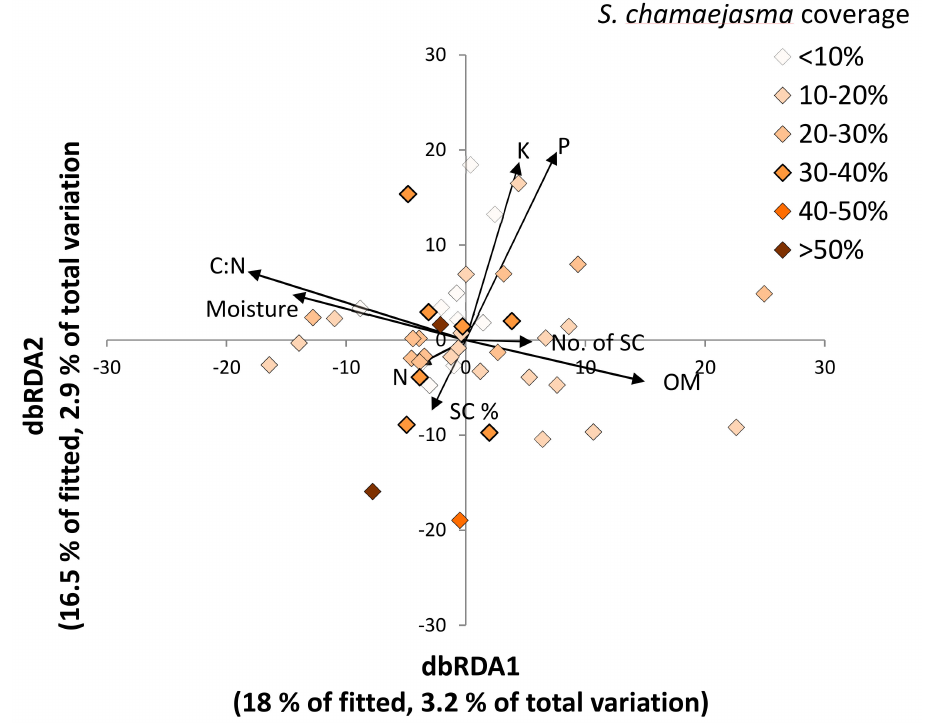
Figure 6. dbRDA plot of global fungal communities in the invaded site ( n = 46) relating variations in fungal populations with soil and S. chamaejasme cover and abundance. Invaded site only. Nutrient, moisture and organic matter are % total (C = carbon, N = nitrogen, P = phosphorous, K = potassium, moisture, and OM = organic matter). SC = % cover and abundance of S. chamaejasme per quadrat; No. of SC = number of S. chamaejasme per